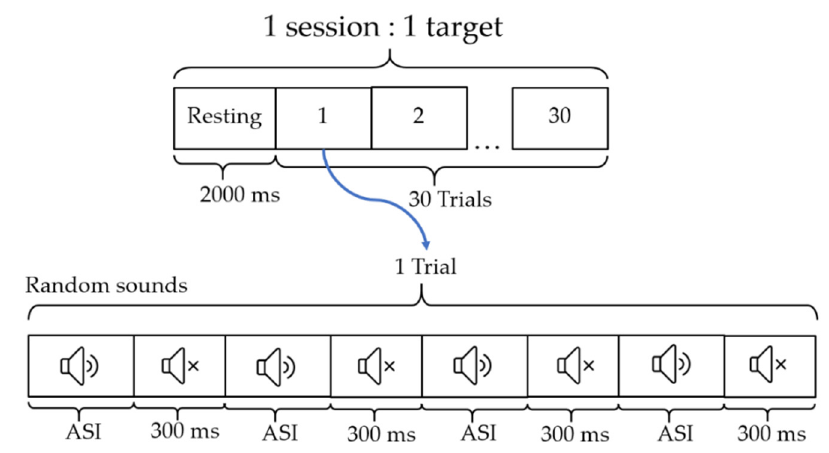
Figure 3. Experimental paradigm of the auditory stimulus to investigate the proposed auditory stimuli and the pattern of loudspeaker position settings. (Auditory stimulus intervals (ASI): 100 and 250 ms). Table 3. Target of the auditory ERP components using stimuli as vowel sounds with a duration of 100 and 250 ms.